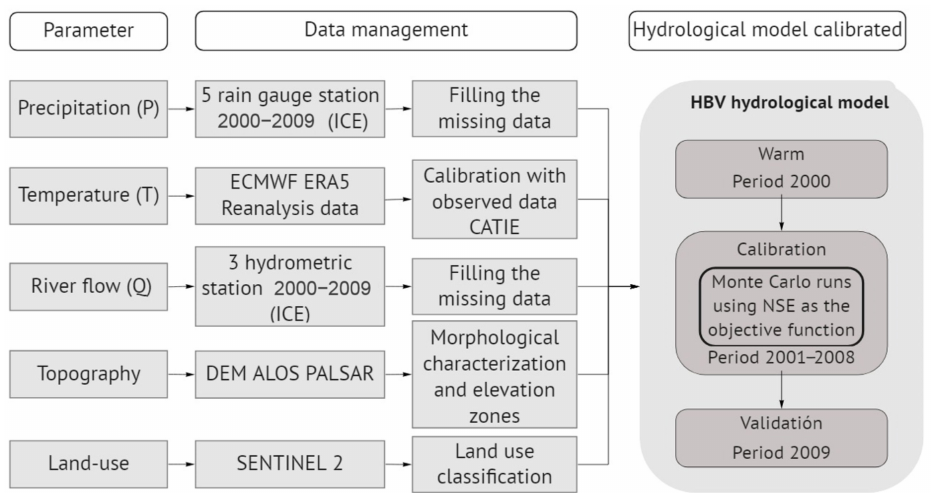
Figure 2. Diagram of the hydrologic model generation and calibration process.